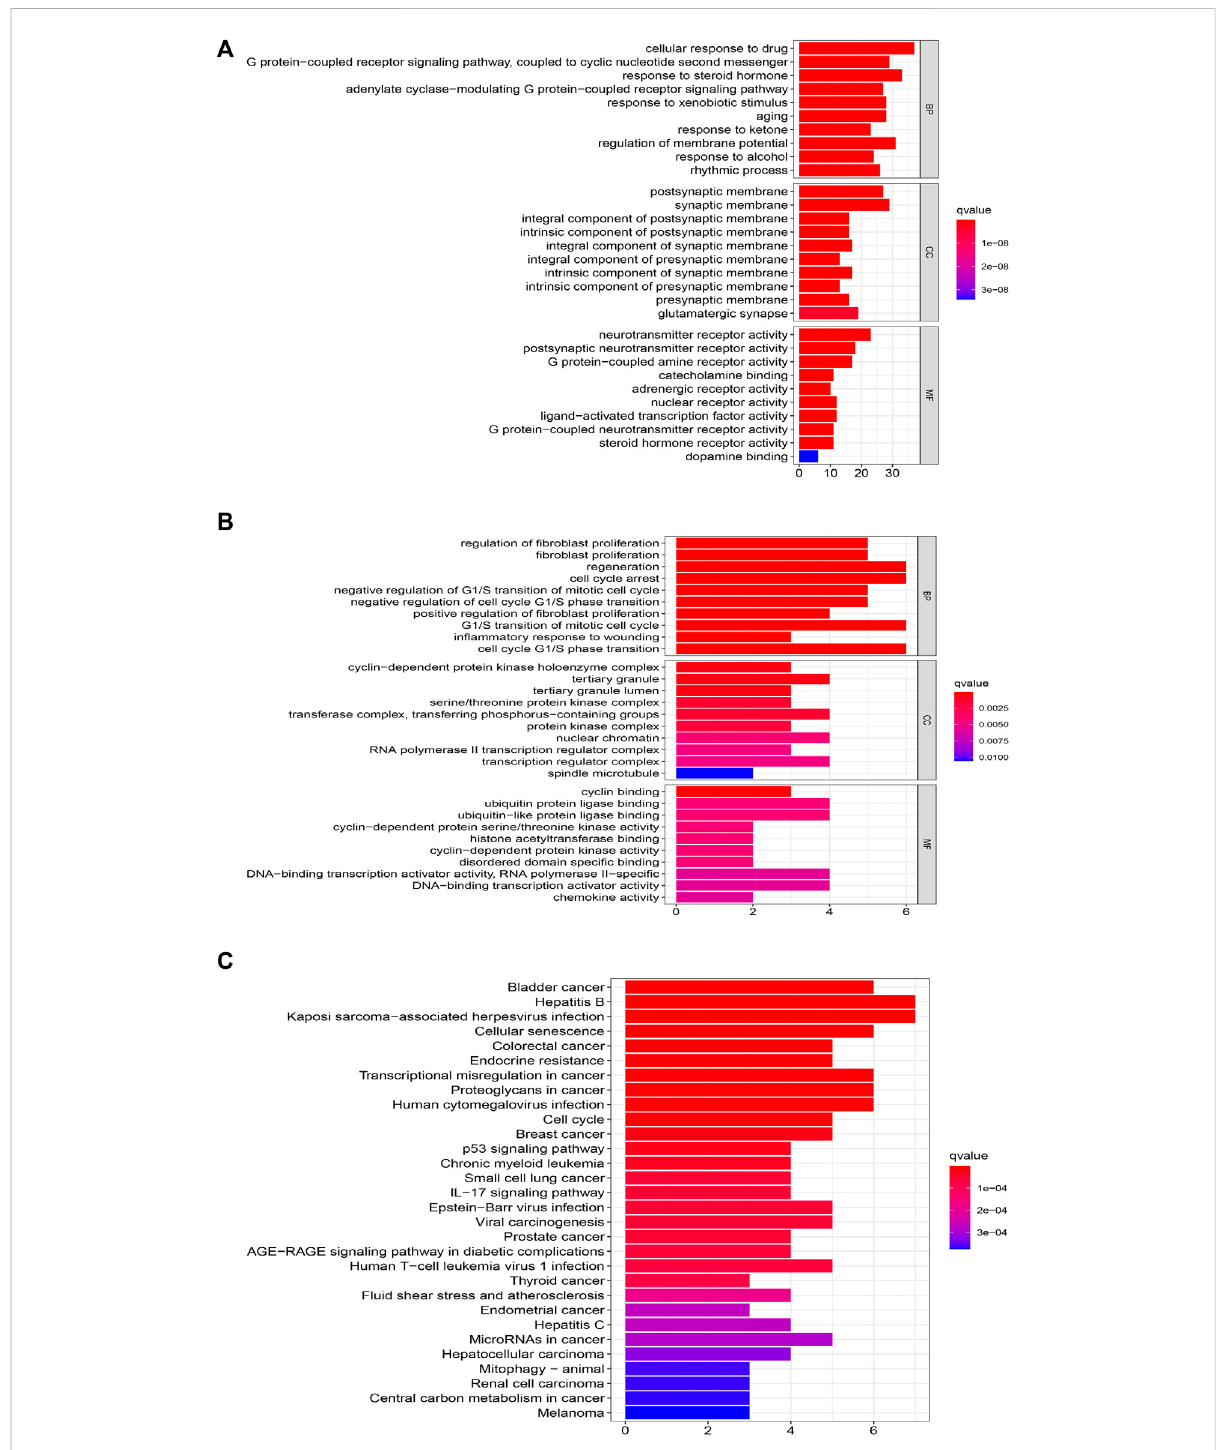
FIGURE 6 Functional GBM analysis of XLD targets and GBM differential genes. (A) GO functional enrichment analysis XLD targets. (B,C) GO and KEGG functional enrichment analysis of common targets of XLD and GBM. The size of the bubble indicates the number of enrGBMed genes, and the color indicates qvalue and Pvalue. XLD, Xiaoliu Decoction; GBM, glioblastoma multiforme; GO, Gene Ontology; KEGG, Kyoto Encyclopedia of Genes and Genomes; BP, biological process; CC, cell components; MF, molecular